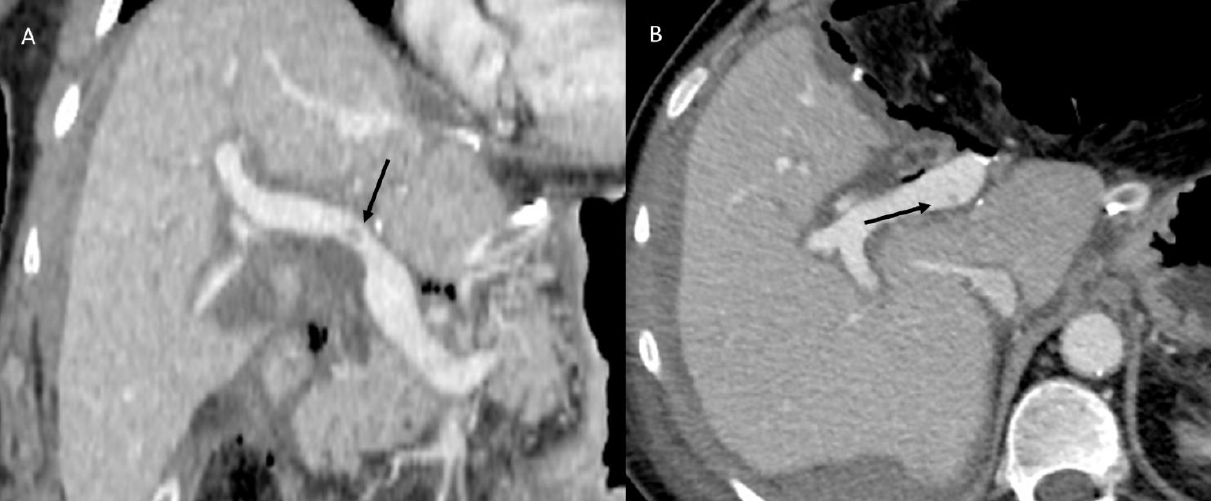
Figure 6. CT portal phase assessment in resected liver metastases patient. The arrow shows ( A , B ) mild portal thrombosis. portal